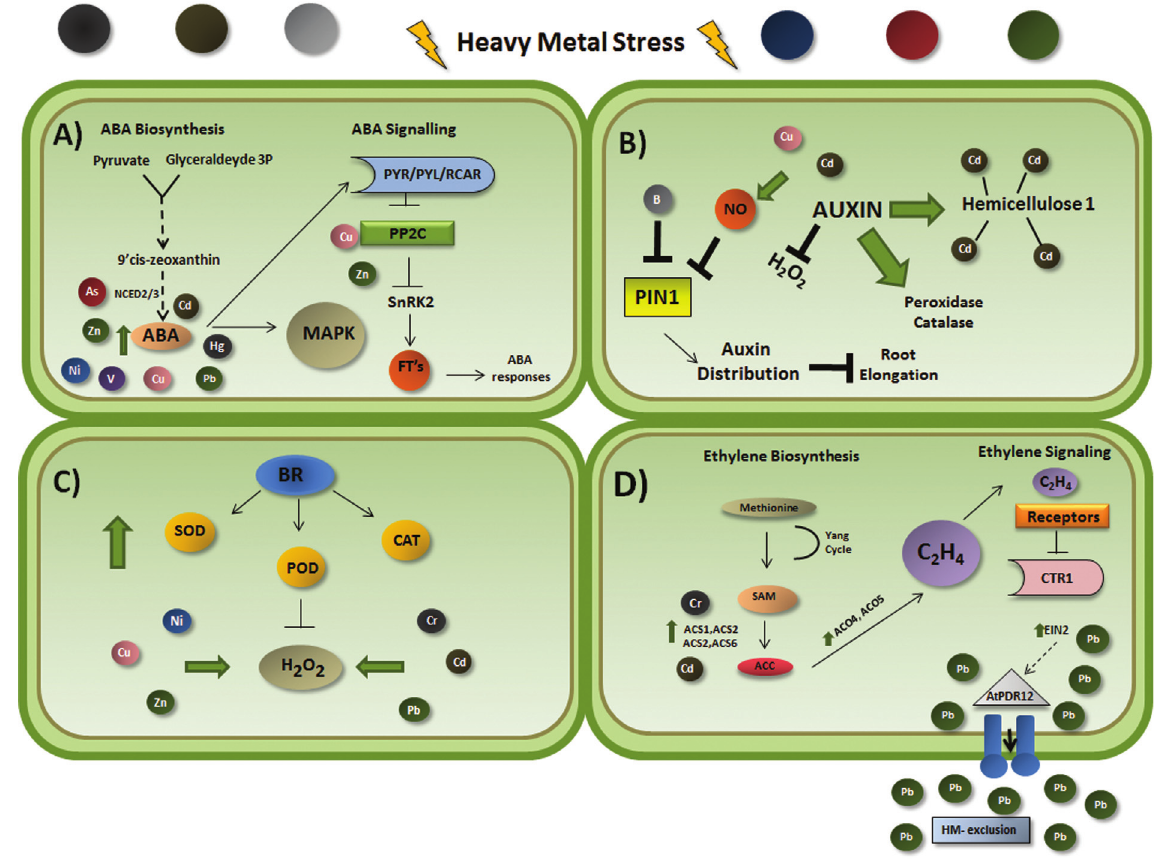
Figure 1 - Schematic representation showing some interactions between the plant hormones abscisic acid (A), auxin (B), brassinosteroids (C) and ethyl- ene(D)underheavymetalexposure.(A)Cd,Cu,Hg,Ni,PbandZntreatmentsincreaseendogenouslevelsofABA.UnderAsstress, NCED2 and NCED3 (ABA biosynthesis genes) are up-regulated. Vanadium (V) is also shown to trigger the expression of genes associated with ABA signaling and biosynthesis. The genes PYL , PP2C and SnRK2 that are putatively involved in ABA signal transduction were identified under Cu and Zn exposure. (B) Under B starvation PIN1 changes auxin distribution and possibly inhibits root elongation. Cd induces NO accumulation, which represses auxin transport and reduces root meristem size. NO is also involved in the auxin signaling pathway in response to Cu exposure. Under Cd stress, an auxin conjugate (IAA-Asp) modulates catalase and peroxidase activity and decreases hydrogen peroxide concentration. In the same condition, auxin (NAA) increases hemicellulose 1 content and more Cd is fixed in the roots. (C) BRs induce SOD, CAT and POD activities, protecting plants against heavy metal toxicity. (D) ACS and ACO expression leads to higher production of ethylene. ACS2 and ACS6 are regulated by MPK3/MPK6 at transcriptional and translational levels. MPK3 and MPK6 phosphorylate the transcription factor WRKY33, which in turn regulates ACS2 and ACS6 gene expression. The WRKY33 pro- tein also binds directly to ACS2 and ACS6 promoters. EIN2 is an important component of the ethylene signaling pathway and acts as a transducer of stress response. Lead treatment increased the transcript levels of EIN2 in Arabidopsis seedlings under heavy metal exposure. It has been suggested that EIN2 regulates AtPDR12, an ABC membrane-transporter that excludes Pb and Pb-containing toxic compounds from the cytoplasm. Dashed black line indi- cates possible regulation. Arrows and T-bars represent positive and negative regulation, respectively. Green arrows indicate increased levels. As, arsenic; B, boron; Cd, cadmium; Cr, chromium; Cu, copper; Hg, mercury; Ni, nickel; Pb, lead; Zn, zinc; V, vanadium; FT’s, transcription factors; NO, nitric ox- ide; BRs, brassinosteroids; SOD, superoxide; CAT, catalase; POD, peroxidase; ACS, ACC synthetase; ACO, ACC